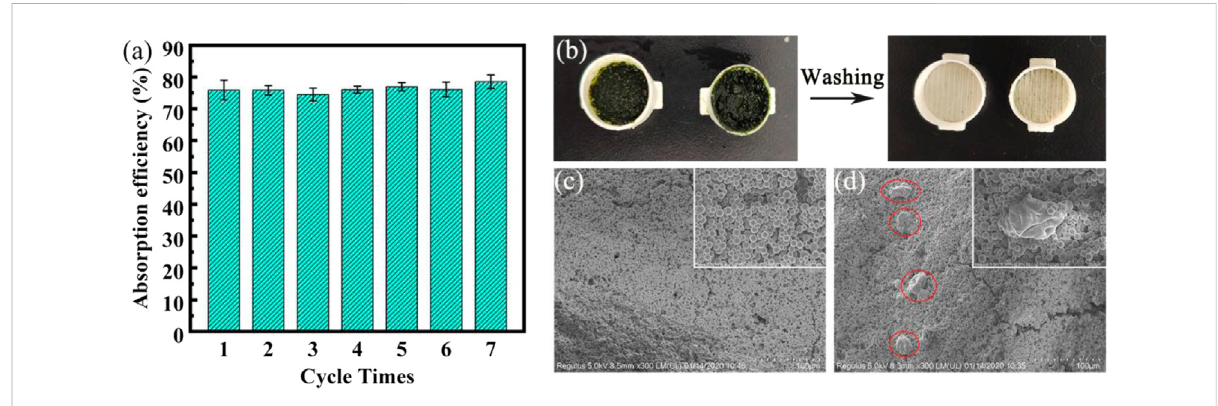
FIGURE 9 (A) Cyclic adsorption performance chart; (B) Capsule diagram after adsorption; (C,D) SEM images of capsules before and after